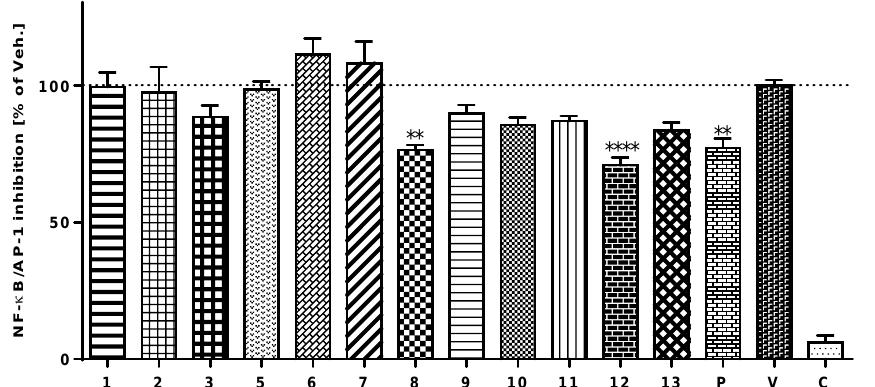
Figure 3. Effect of compounds 1 – 3 , 5 – 12 , and 13 ( a + b ) on NF- κ B/AP-1 activity. THP-1-XBlue™-MD2-CD14 cells were pre-treated for 1 h with the test compounds (5 µ M dissolved in DMSO), prednisone (P; 5 µ M dissolved in DMSO), with only the vehicle (V). Subsequently, LPS (1 µ g/mL) was added (to all but C, control cells) to trigger the activation of NF- κ B/AP-1. After 24 h, the activity of NF- κ B/AP-1 was evaluated based on the amount of secreted alkaline phosphatase measured spectrophotometrically. The results are expressed as the mean ± SE for six independent experiments measured in triplicate. ** indicates a significant difference ( p < 0.01) in comparison with the vehicle-treated cells and **** indicates a significant difference ( p < 0.0001) in comparison with the vehicle-treated cells.